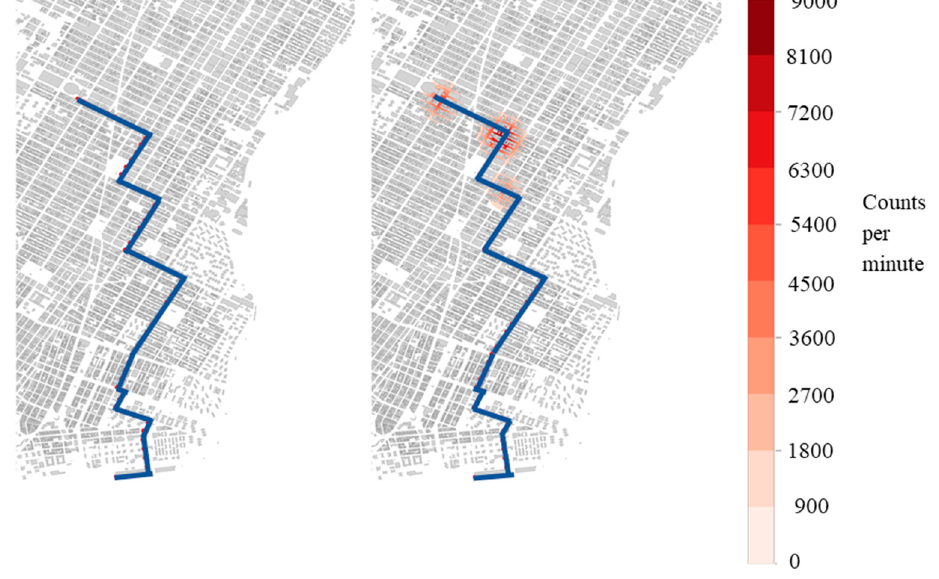
Figure 4. Detection heat maps. Maps show the counts per minute above background detected for a single route from a 400-vehicle mobile detector array of a 0.1 Ci Co-60 (left — case 8) and a 0.5 Ci Co-60 (right — case 11) source moving at 10 m/s.